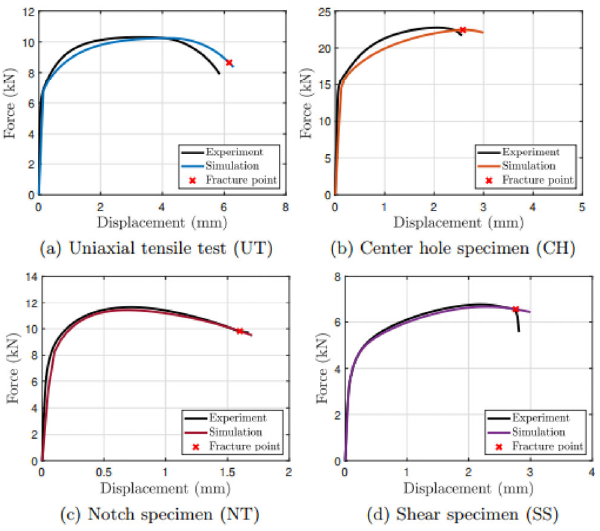
Fig. 9 Comparison of experimental and FE simulated force– displacement data for (a) UT, (b) CH, (c) NT, and (d) SS specimen (the red color marked symbols represent the onset of